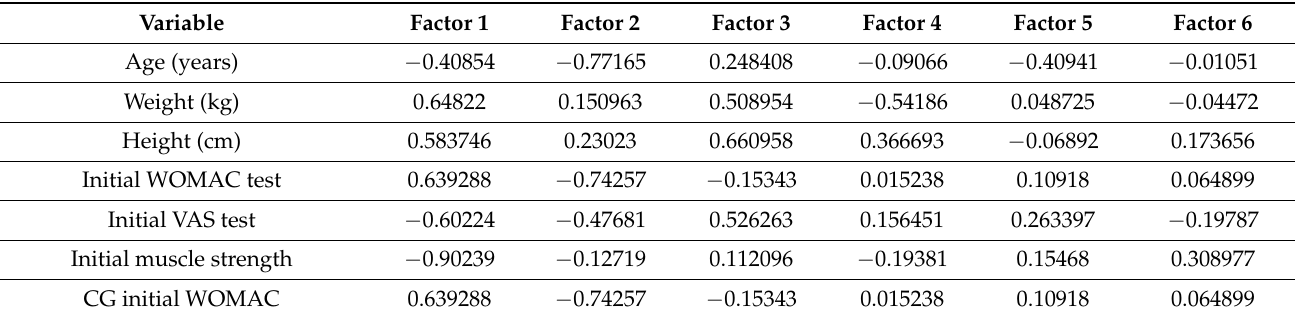
Table 8. Factor coordinates of the variables based on correlations for the pilot group (PG) at the Table 9. Factor coordinates of the variables based on correlations for the control group (CG) at the initial stage. initial stage.